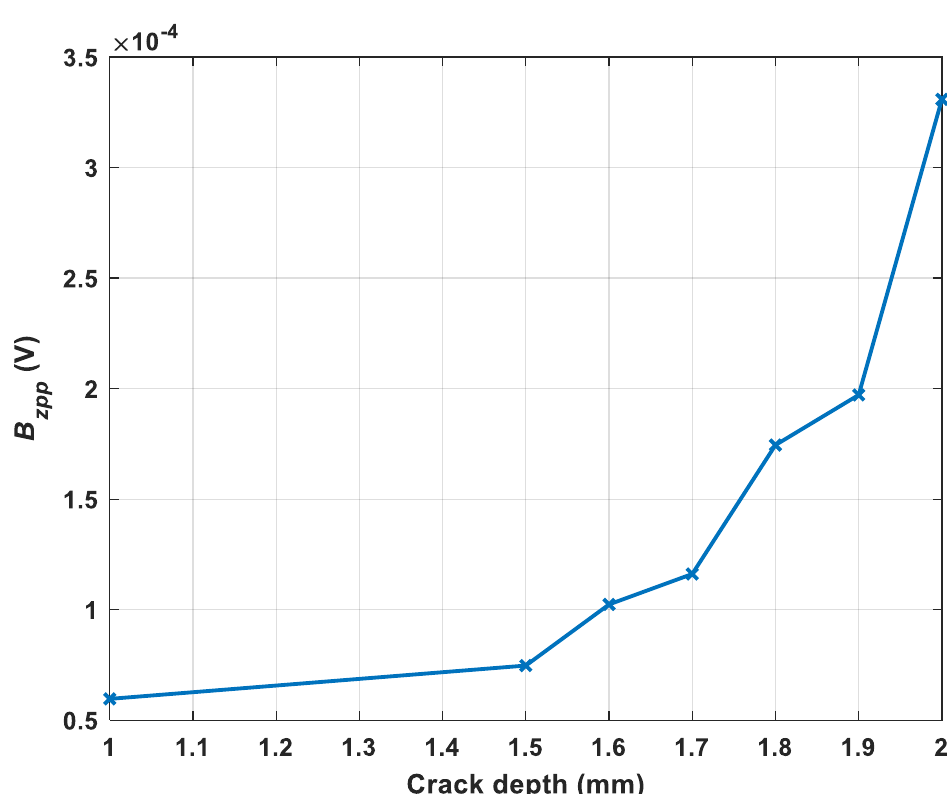
Figure 11. The peak-to-peak value of z component of the magnetic field with different crack depths under the frequency of 20 kHz.